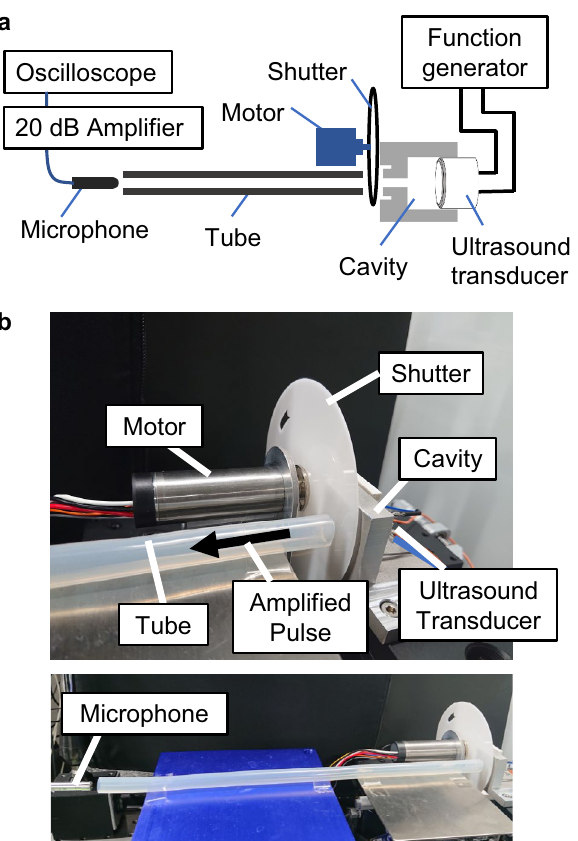
Figure 4. ( a ) Schematic of the experimental setup. ( b ) Photo of the experimental